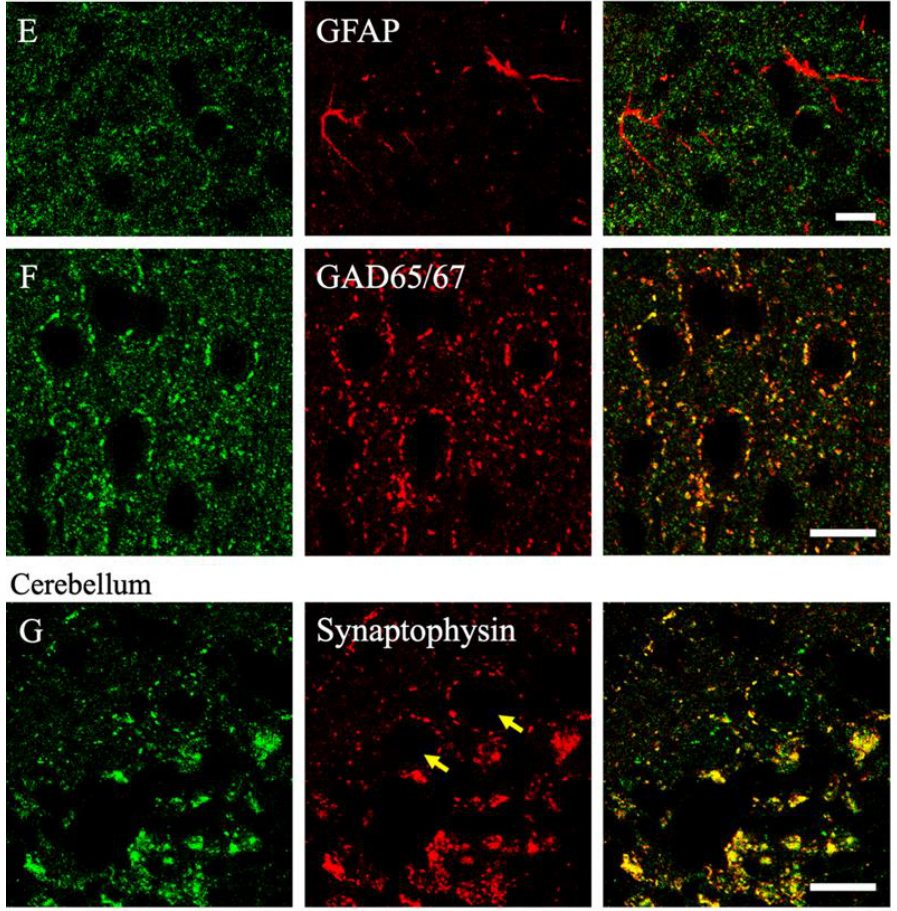
Figure 4. Laser scanning microscopic images of the double immunofluorescence images of the cerebral cortex ( A – F ) and cerebellum ( G ) are shown. Green color indicates the immunoreactivity of MGRN1 (left panels) and red color shows the immunoreactivity of each cell marker (middle panels); merged pictures are shown in the right panels. Yellow arrows in G indicate the Purkinje cells in the cerebellum. All scale bars are 10 μm.